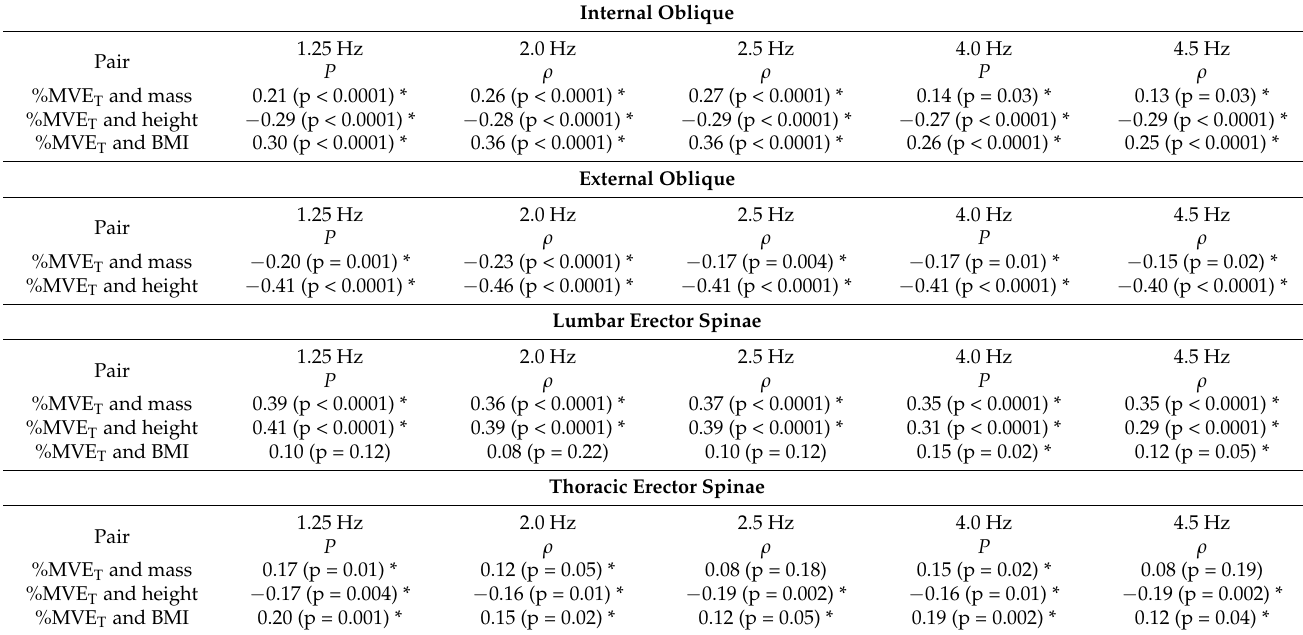
Table 2. Spearman’s rank coefficient of correlation for pairwise comparison of BMI (body mass index), mass, and height with %MVE T (transformed % maximum voluntary electrical activation data) in the internal oblique, external oblique, lumbar erector spinae and thoracic erector spinae after back muscle fatigue. Spearman’s rho ( ρ ) values denoted with * are statistically